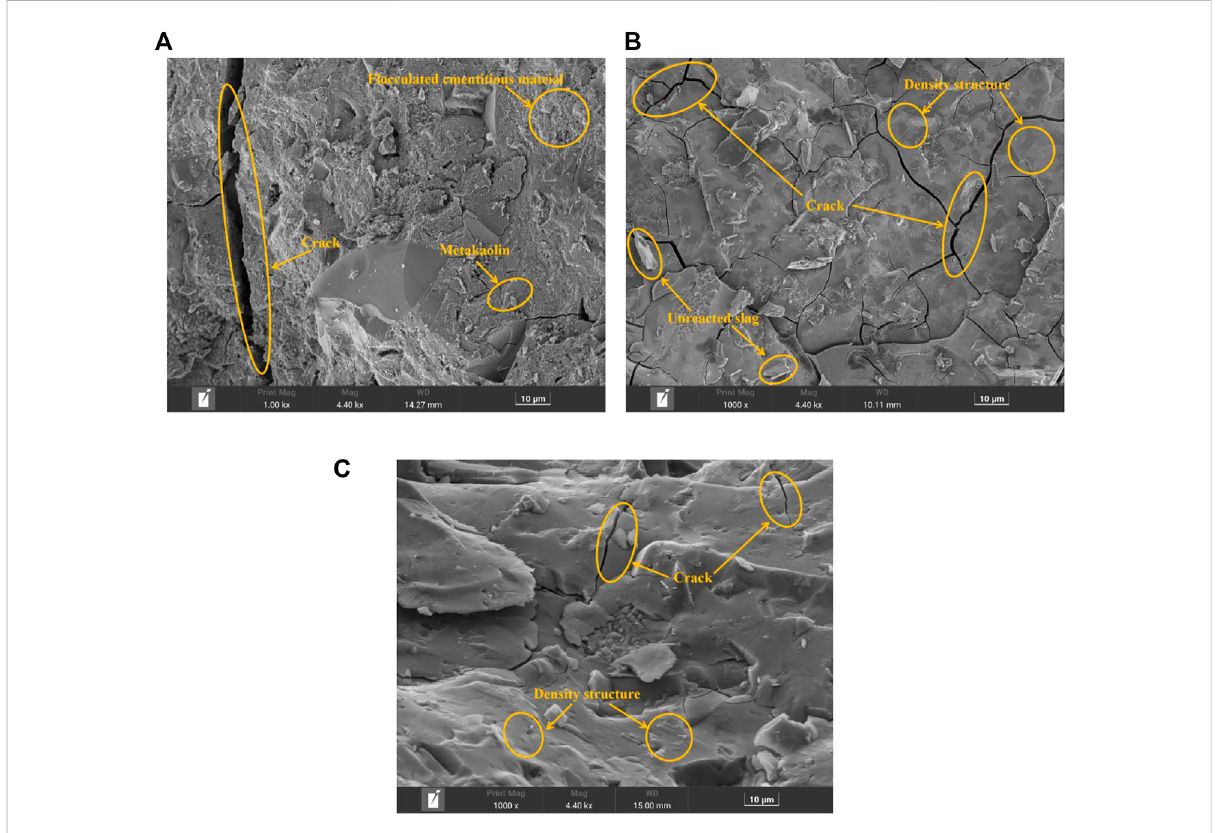
FIGURE 8 Micromorphologies of AASM. (A) Interaction between Na 2 O and activator modulus; (B) Interaction between Na 2 O and metakaolin; and (C) Interaction between activator modulus and